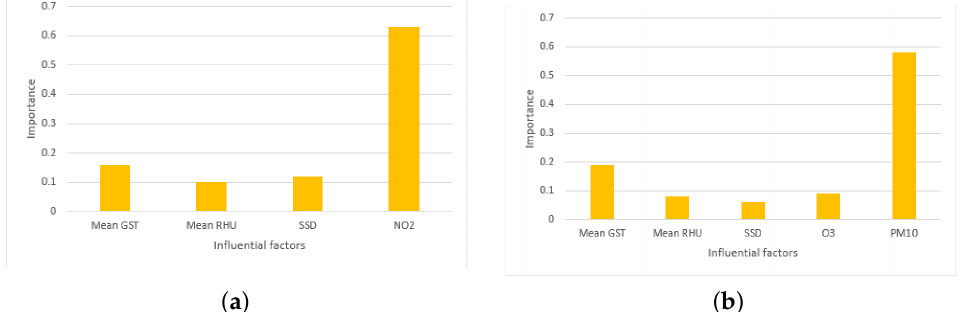
Figure 13. The importance of predictor variables of RFR for ( a ) CO and ( b ) NO 2 at Ma Lian